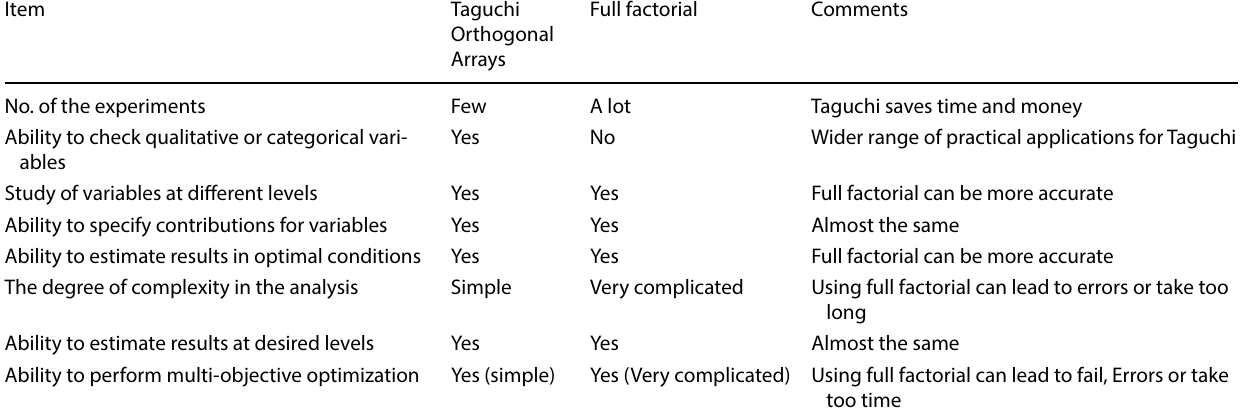
Table 2 Comparison of the design of experiments by Taguchi orthogonal arrays with the full factorial method